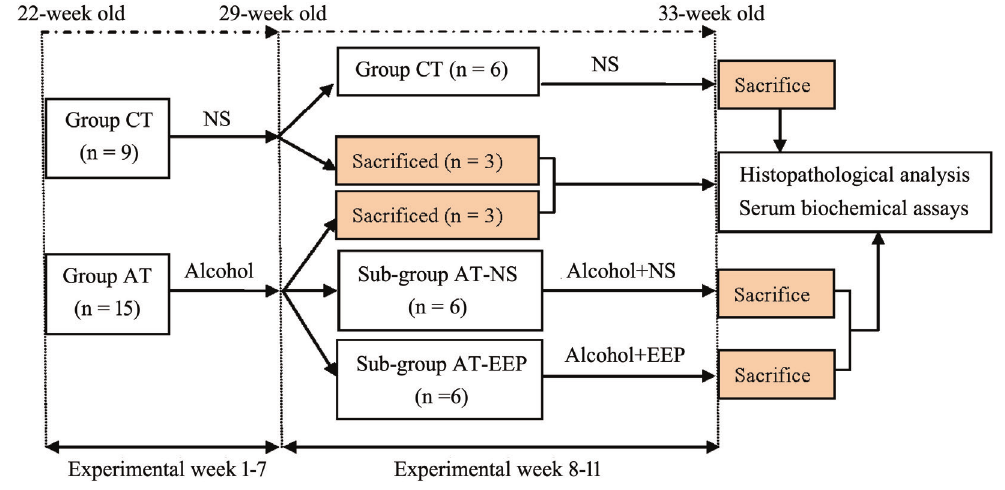
Figure 1 - Experimental design of the present study. Group CT, control; Group AT, treated with alcohol; Sub- group AT-NS and Sub-group AT-EEP, treated with alcohol and co-administered with normal saline (NS) and EEP,